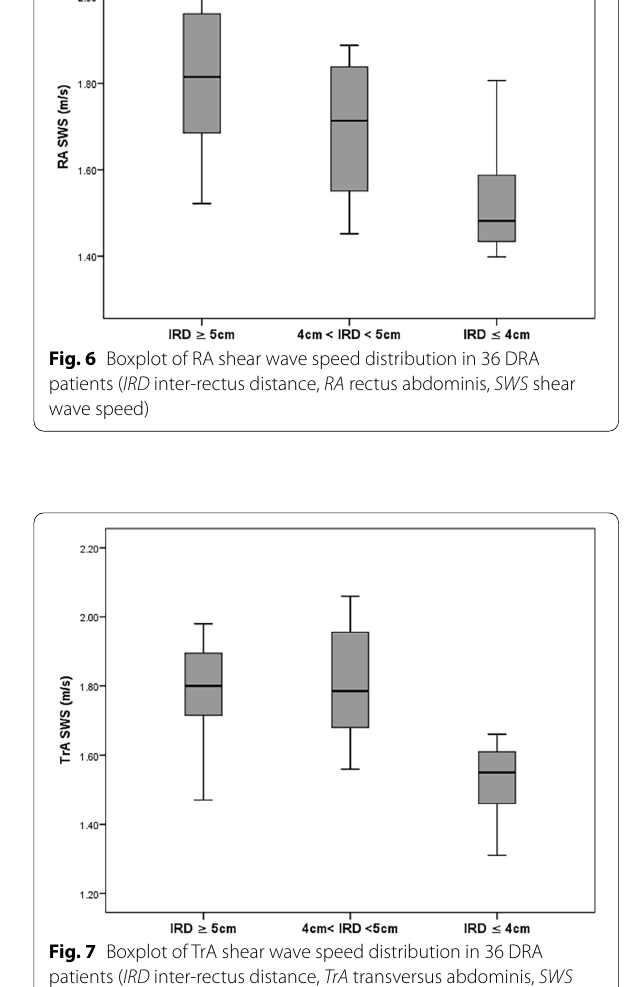
Table 3 Comparison of shear wave speed of abdominal wall muscles at different locations